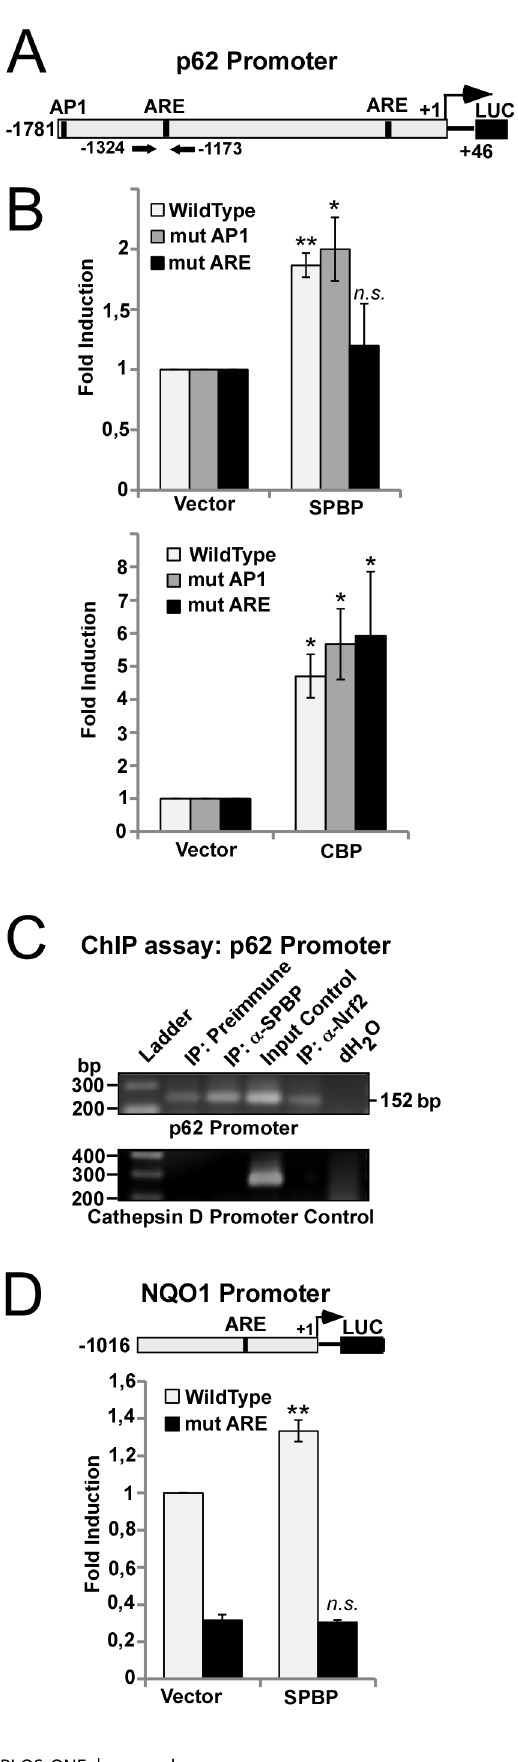
Figure 2. SPBP mediates transcriptional activation via ARE elements. ( A ) Schematic representation of the human 2 1781/ + 46 p62 promoter construct in front of the Luciferase gene. Conserved transcription factor binding sites relevant for this study are indicated. ( B ) Mutation of the ARE elements impairs SPBP mediated activation of the p62 promoter. Transient transfections were carried out in HEK293 cells using 60 ng of wild-type or mutated reporter vectors, and 100 ng of expression vectors for SPBP (upper panel) or CBP (lower panel). The data represent the mean of three independent experiments with standard deviations, each performed in triplicate (**p , 0.01, *p , 0.05, n.s. not significant). ( C ) Chromatin immunoprecipitations show that SPBP is associated with the p62 promoter. HeLa cell extracts (1.5 6 10 7 cells per antibody) were immunoprecipitated with preimmune serum, polyclonal anti-SPBP antibody or polyclonal anti-NRF2 antibody. Input Control (1:40) was included. PCR was performed on chromatin precipitated with each antibody using primers aligning to positions 2 1324/ 2 1173 in the p62 promoter (upper panel). Primers aligning to positions 2 3351/ 2 3069 of the cathepsin D promoter were used as control. ( D ) SPBP mediated enhancement of the NQO1 promoter is dependent on the ARE element. Transient transfections were carried out in HEK293 cells using 60 ng of wild-type or mutated reporter vectors, and 100 ng of SPBP expression vectors. The data shows the mean of three independent experiments with standard deviations, each performed in triplicate (**p , 0.01, n.s. not